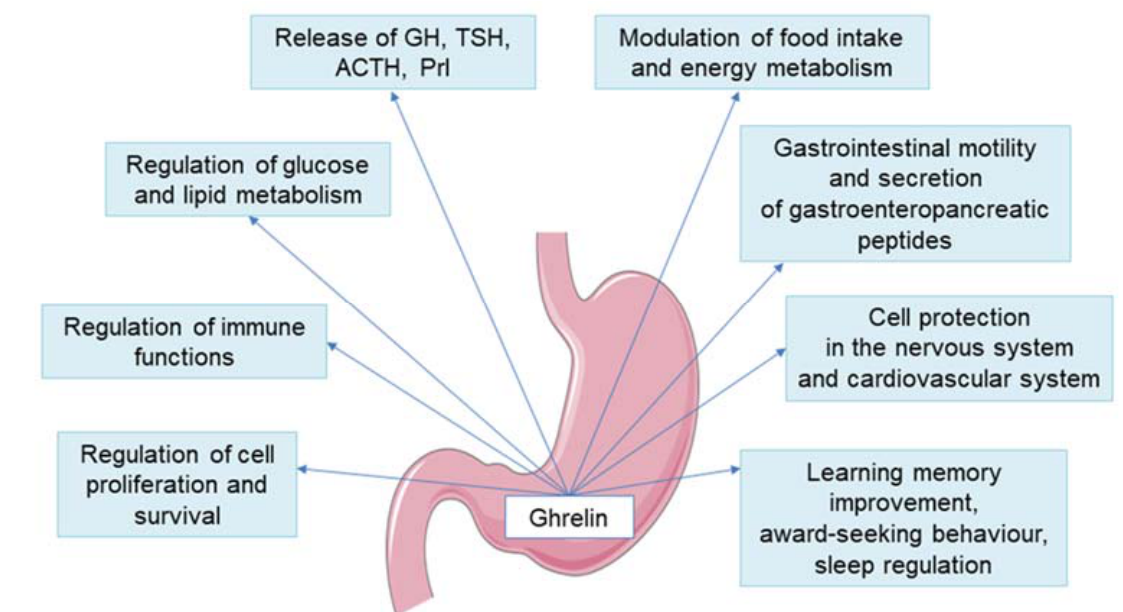
Figure 1. Directions of ghrelin effects on the functions of various systems and organs. ACTH—adrenocorticotropic hormone, GH—growth hormone, Prl—prolactin, TSH—thyroid stimulating hor- mone.